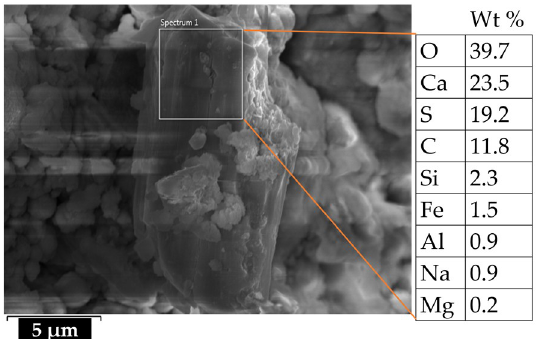
Figure 10. EDX analysis on the rectangular region of interest suspected of gypsum formation on SO-CFA-28 sample.